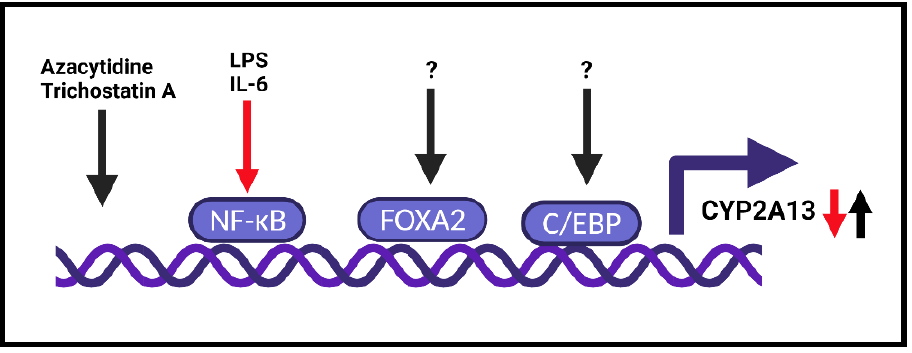
Figure 1. Schematic representation of known transcription regulation of the CYP2A13 gene.: defi- nition. Red arrow connects the tratment process and the result, i.e. downregualtion. Black arrows connect certain treatments/unknown factors the result of which is the CYP2A13 induction.